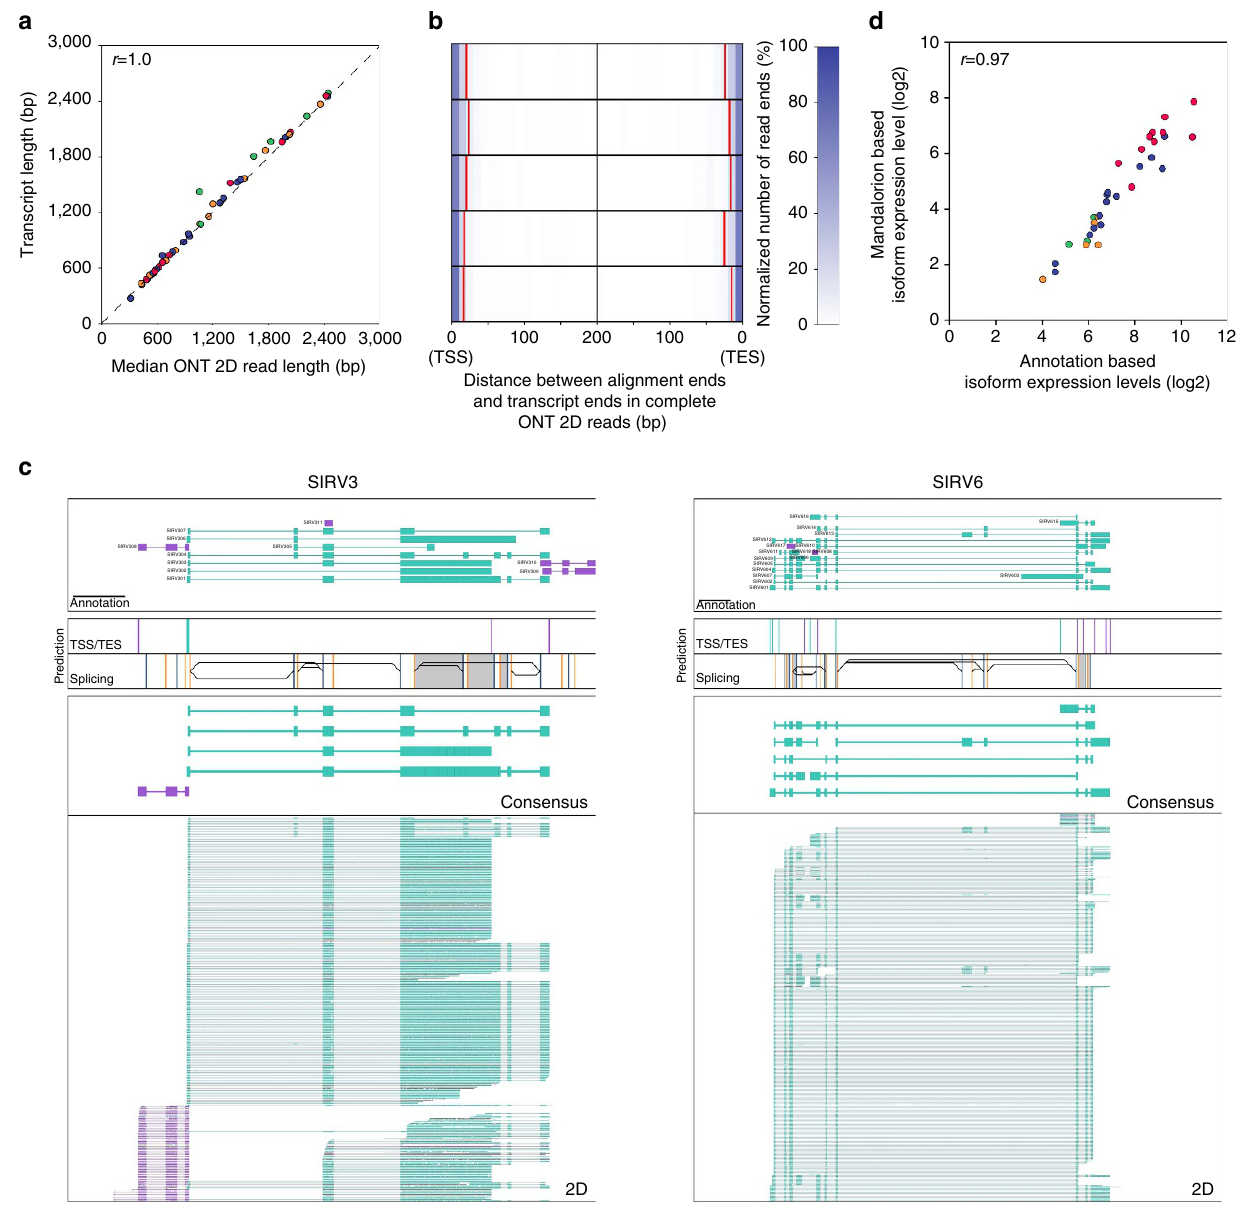
Figure 4 | Identifying and quantifying transcript isoforms in SIRV E2 mixtures. ( a ) Scatter plot shows correlation between ONT 2D reads and the SIRV transcripts they align to. Pearson r is shown. Colouring is as indicated in Fig. 3e–g ( b ) Distance between read alignment ends and transcript ends are shown as heatmap with the colour indicating the normalized alignment numbers. 90% of read alignments terminated outside the red lines ( c ) Genome Browser view of SIRV3(c) and SIRV6(d) gene loci. Top box contains transcript annotations with black 1kb scale bar in bottom left corner, second and third box contain TSS (Teal)/TES (Purple) and splice sites (yellow: 5 0 SS, blue: 3 0 SS) locations predicted from the read data, respectively. Black lines and grey areas in box 3 indicate alternative splicing and intron retention events predicted from the read data. Box 4 contains read alignments of isoform consensus reads. Box 5 contains ONT 2D read alignments. Direction of transcripts, isoform consensus, and ONT 2D reads are indicated by their colour (Teal: 5 0 to 3 0 , Purple: 3 0 to 5 0 ). ( d ) Scatter plot shows correlation between SIRV transcript quantification by aligning to annotated transcripts or by annotation-independent isoform grouping using Mandalorion. Pearson r is